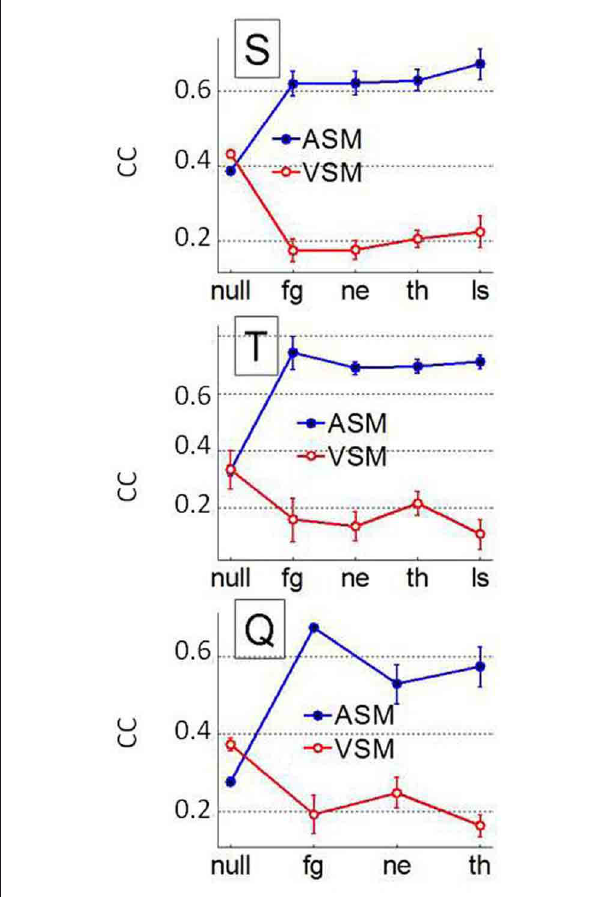
FIGURE 11 | Interindividual differences over the whole population of faces and non-face images (NULL) using the AuROC 2D correlation coefficient as figures of merit. Mean and 95% confidence interval around the mean for the correlation coefficient (CC) between the HotFix and ASM/VSM computed for each monkey. Ensemble bursting in the primates’ amygdala is a better predictor of fixations over faces than low level visual features but interindividual differences in prediction across facial expression starts to weakly correlate with interindividual differences in behavior (see Figure 4